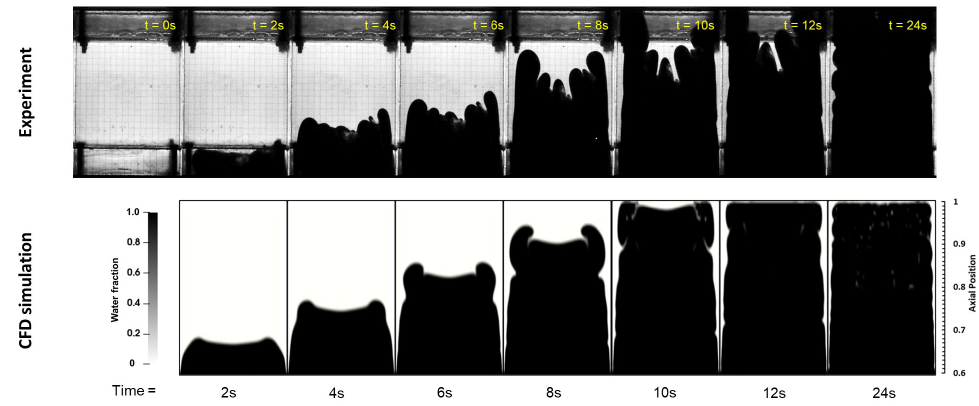
Figure 6. Experimental visualization ( top ) and CFD simulation ( bottom ) of interface evolution of water displacing 0.075 wt.% xanthan gum